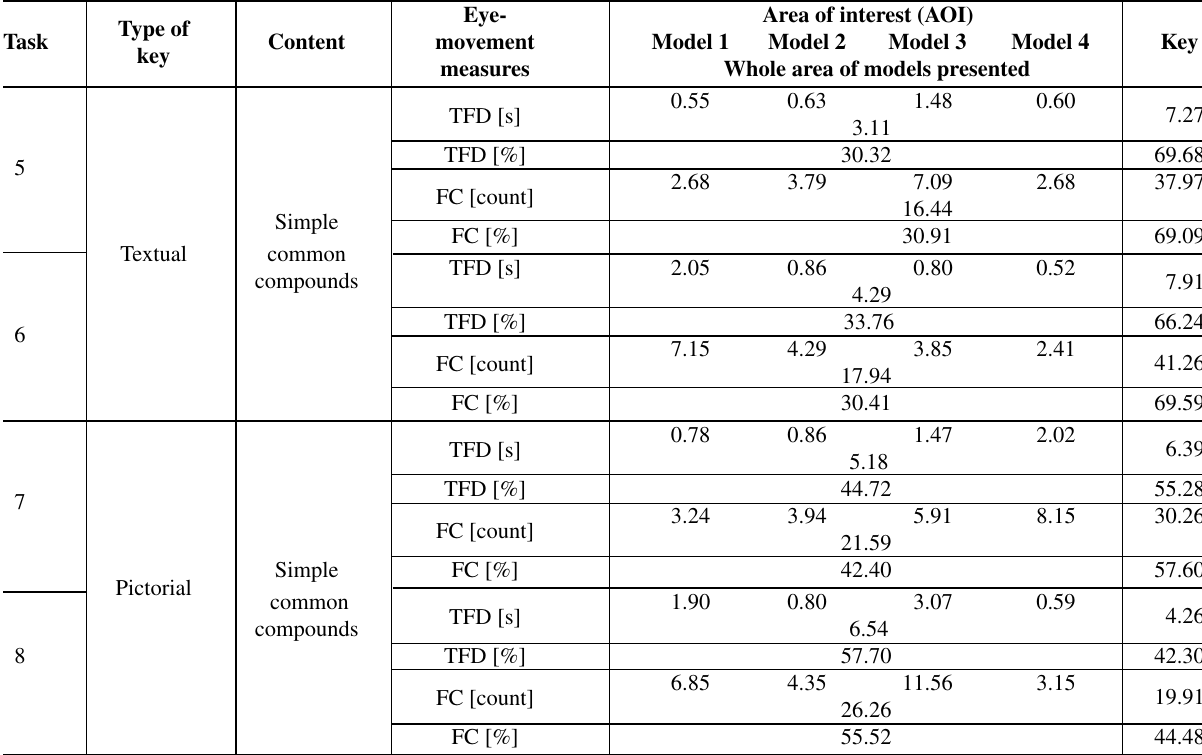
Table 5. Mean values of absolute and relative TFD and FC for tasks 5 to 8. Eye- Area of interest (AOI) Type of Task Content movement Model 1 Model 2 Model 3 Model 4 Key key measures Whole area of models